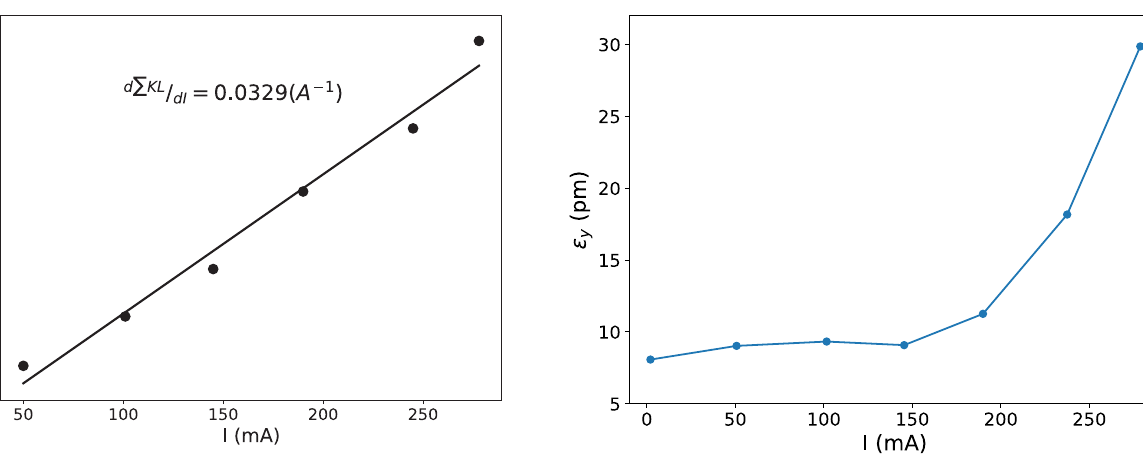
FIG. 13. Vertical emittance is drastically increased when the tune approaches a linear resonance during beam current accumulation.